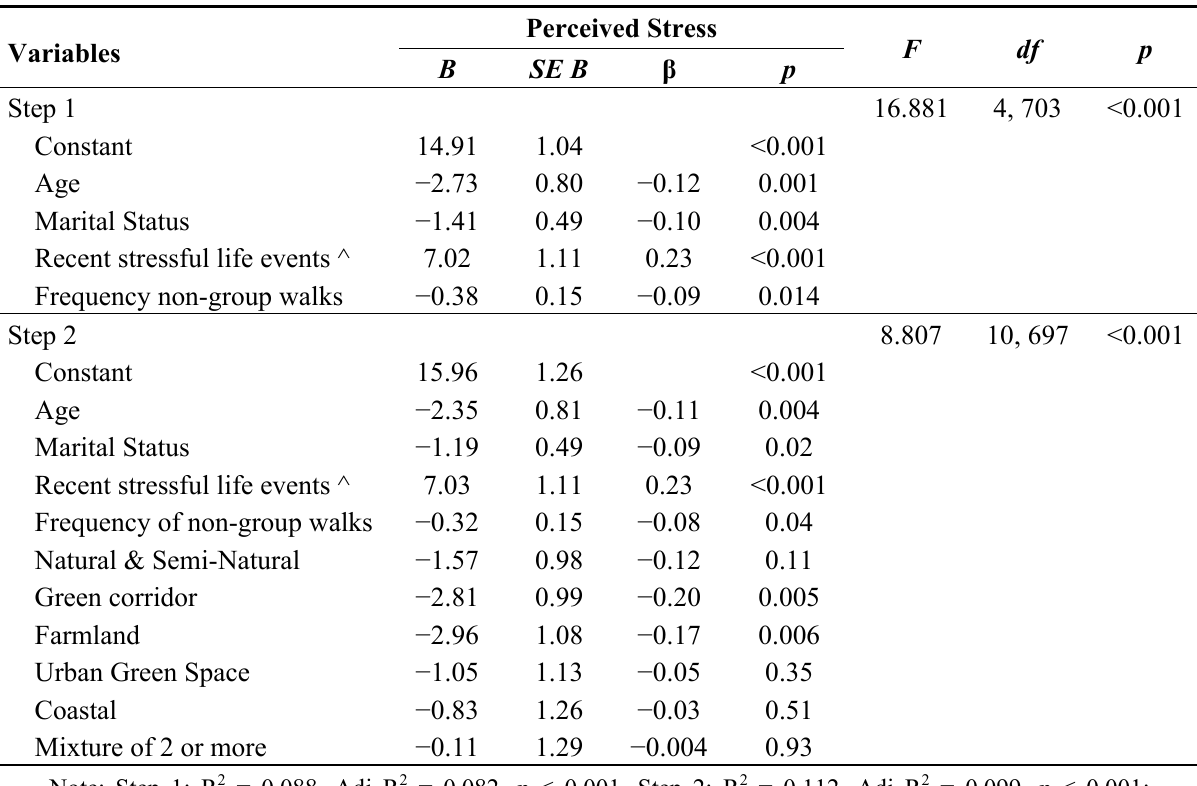
Table 7. Hierarchical regression analyses for variables predicting perceived stress of frequent group walkers attending at least once a week ( n =